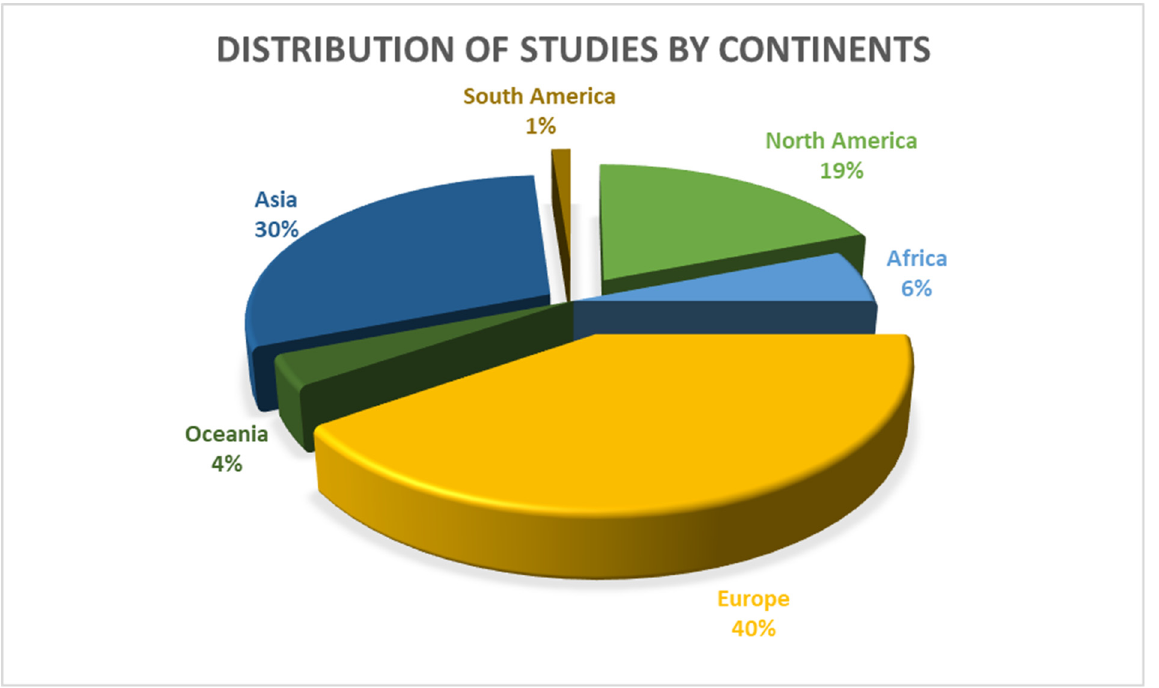
Figure 2. Summary of studies by continents. From Figure 3: Most studies reported on multiple outcomes, indicating the interre- latedness of stress, burnout, anxiety, and depression. Some articles reported on a single outcome, such as stress (N = 9), burnout (N = 8), or depression (N = 6). Burnout and depression (N = 15), stress and depression (N = 5), burnout and anxiety (N = 2), anxiety and depression (N = 4), and stress and anxiety (N = 4), were commonly paired